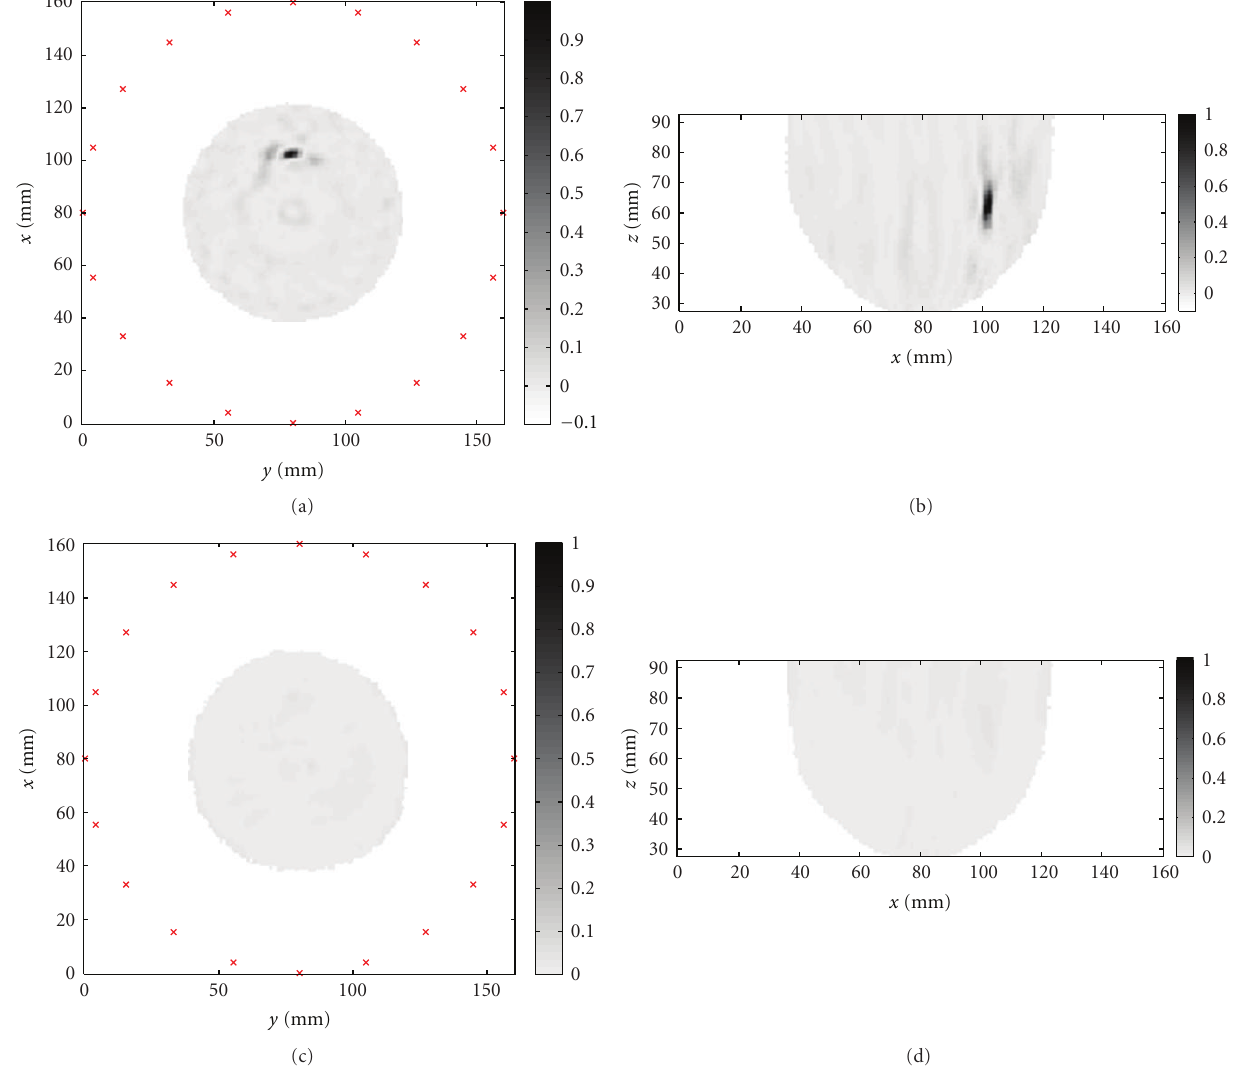
Figure 15: Images of the hemispherical model created from measured data: (a) slice through the inclusion location perpendicular to the axis of the cylinder and (b) slice through the inclusion location parallel to the axis of the cylinder. The images for the phantom without the inclusion are shown in (c) and (d).